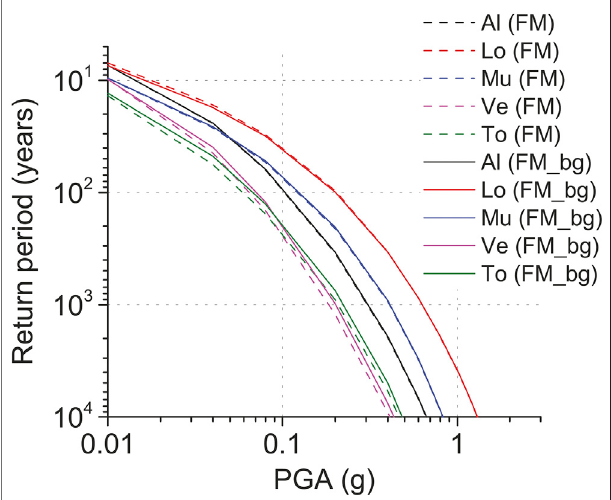
FIGURE 6 | Mean hazard curves for PGA (g) of the FM and FM_bg models in the cities of Almería (Al), Lorca (Lo), Murcia (Mu), Vera (Ve) and Torrevieja (To). Their location is indicated in the maps from Figures 4 , 5